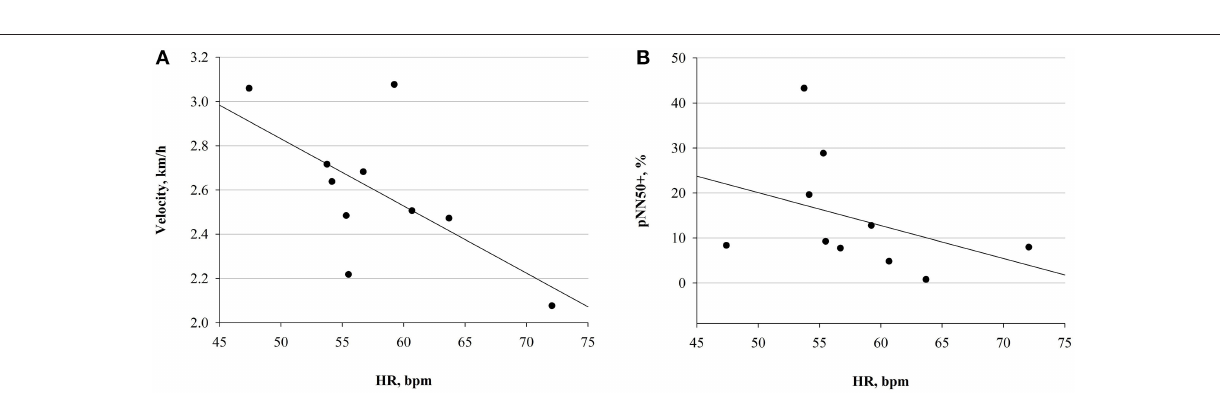
FIGURE 6 | Correlations at PRE in FIN group. (A) Correlation between HR and mean velocity ( r = − 0.63; p = 0.04). (B) Correlation between HR and pNN50 + ( r = − 0.67; p =